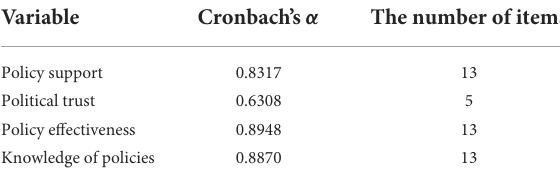
TABLE 4 Reliability test over the